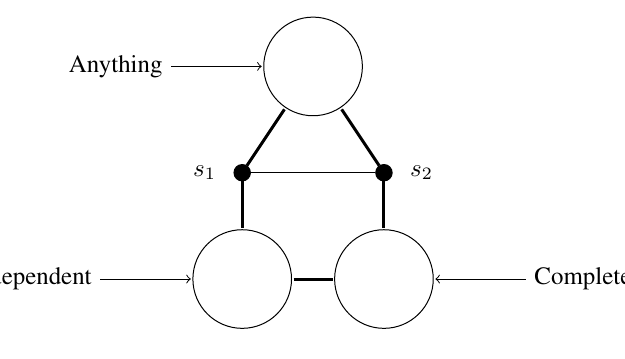
Fig. 1: A starter-matrix class of